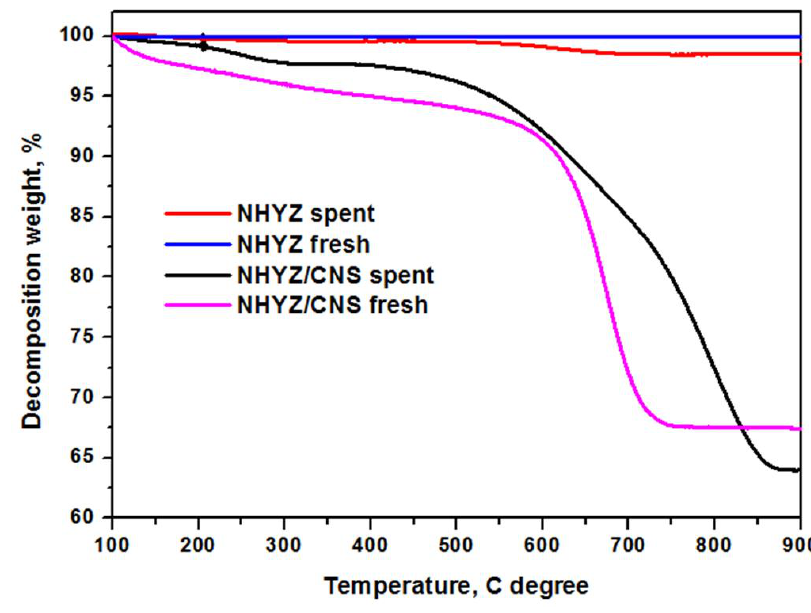
Figure 10. TGA analysis of fresh and spent NHYZ and NHYZ/CNS catalysts.